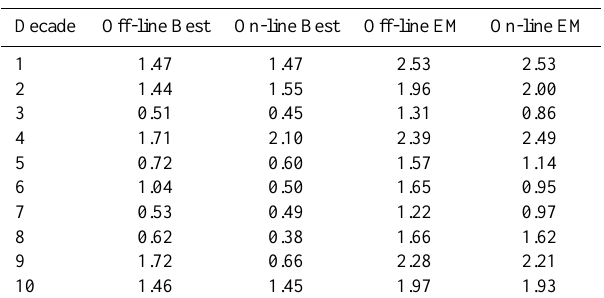
Table 1. Best cost functions for the off-line and the on-line DA schemes, for the decades 1 (1600–1609) to 10 (1690–1699). The respective ensemble mean (EM) cost functions are also shown.